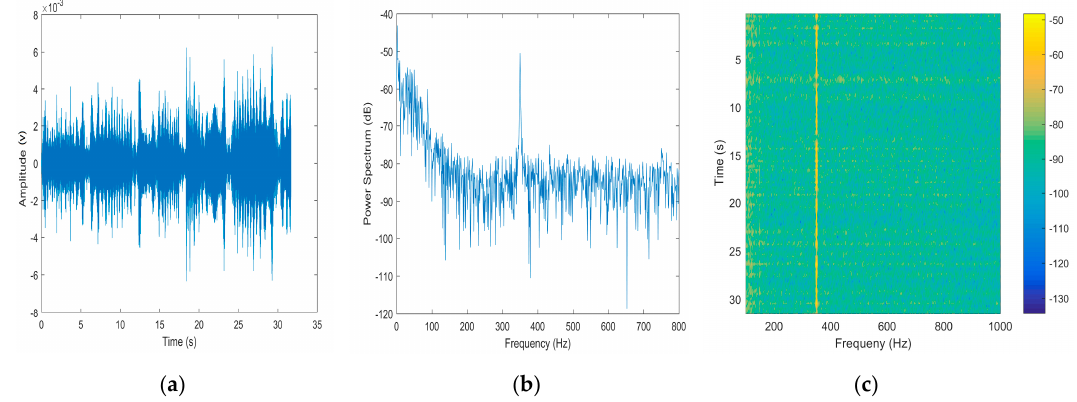
Figure 17. Received signal of the reference element in the shadow zone ( a ) time domain; ( b ) frequency domain; ( c ) time–frequency domain.